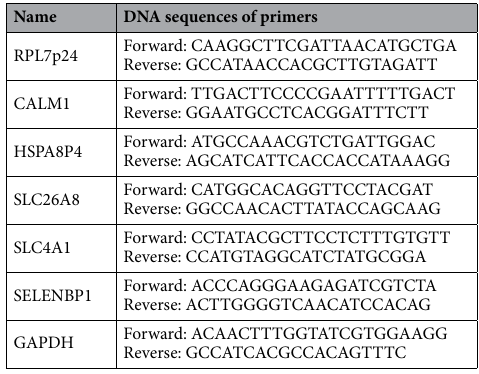
Table 1. DNA sequences of the primers used in this